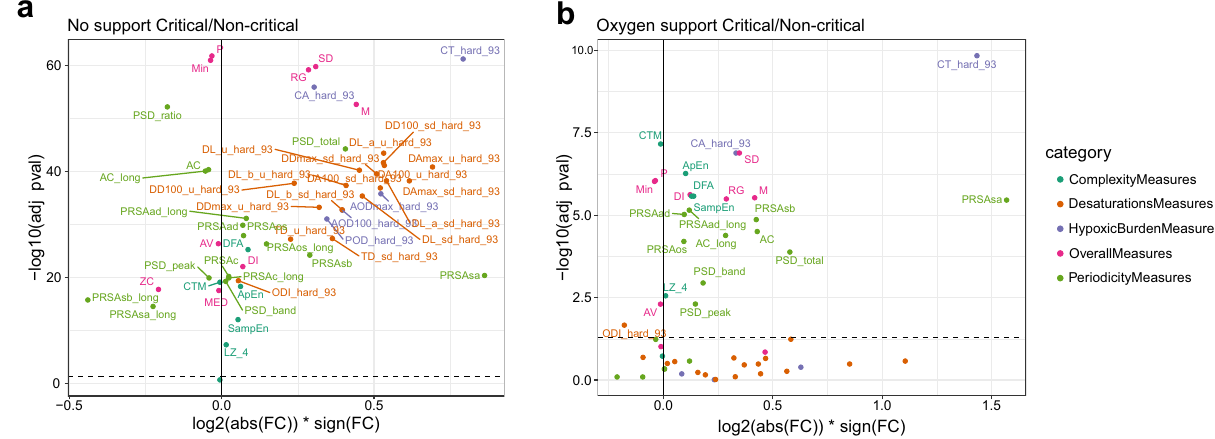
Figure 5. OBMs across the spectrum of disease severity and treatment support. ( a ) Critical versus non-critical without support and ( b ) critical versus non-critical under oxygen support. OBMs definition are available in Table S1. See the Figure S5 for the comparisons between no-support and oxygen support or mechanical ventilation. An OBM with a high significance (− log10 p value) and a large effect size (log2 Fold-change) is able to discriminate between the two groups compared in the figure. OBMs below the dashed horizontal line is insignificant. The most discriminative biomarkers could be used as indicators of patient degradation. Adj pval: FDR Adjusted p value, FC: Fold